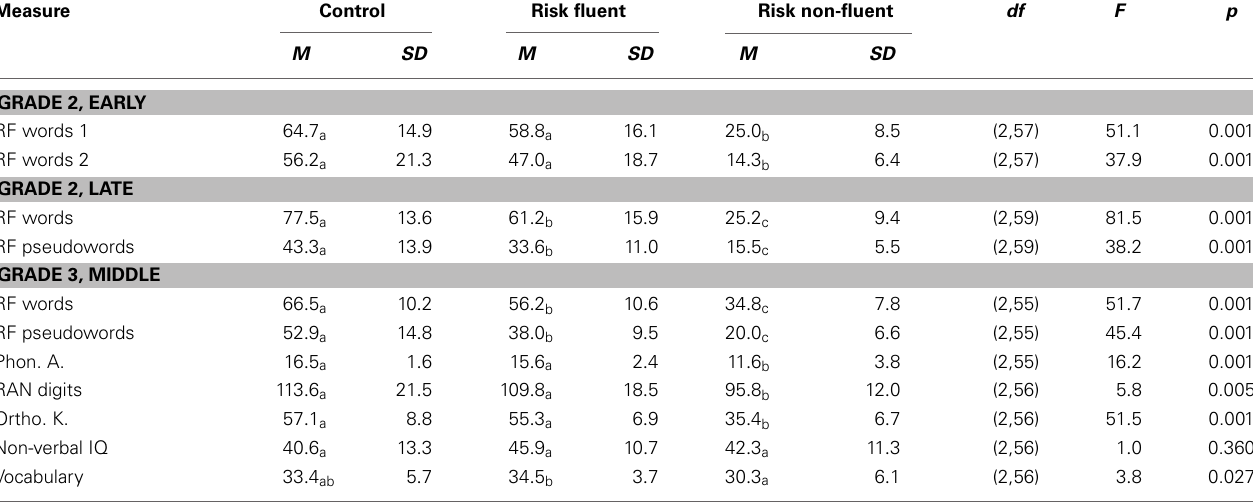
Table 1 | Behavioral